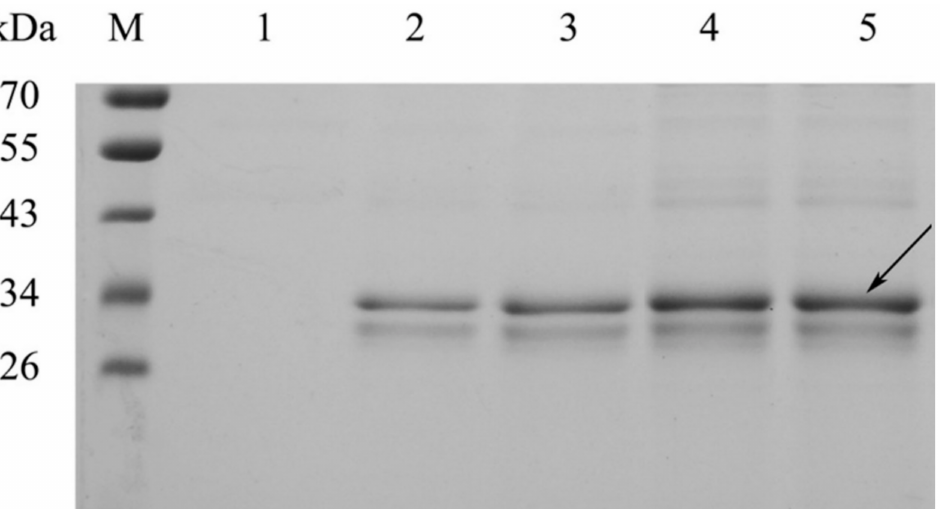
Figure 4. SDS-PAGE analysis of CDA secreted into cell culture supernatants. M, protein molecular